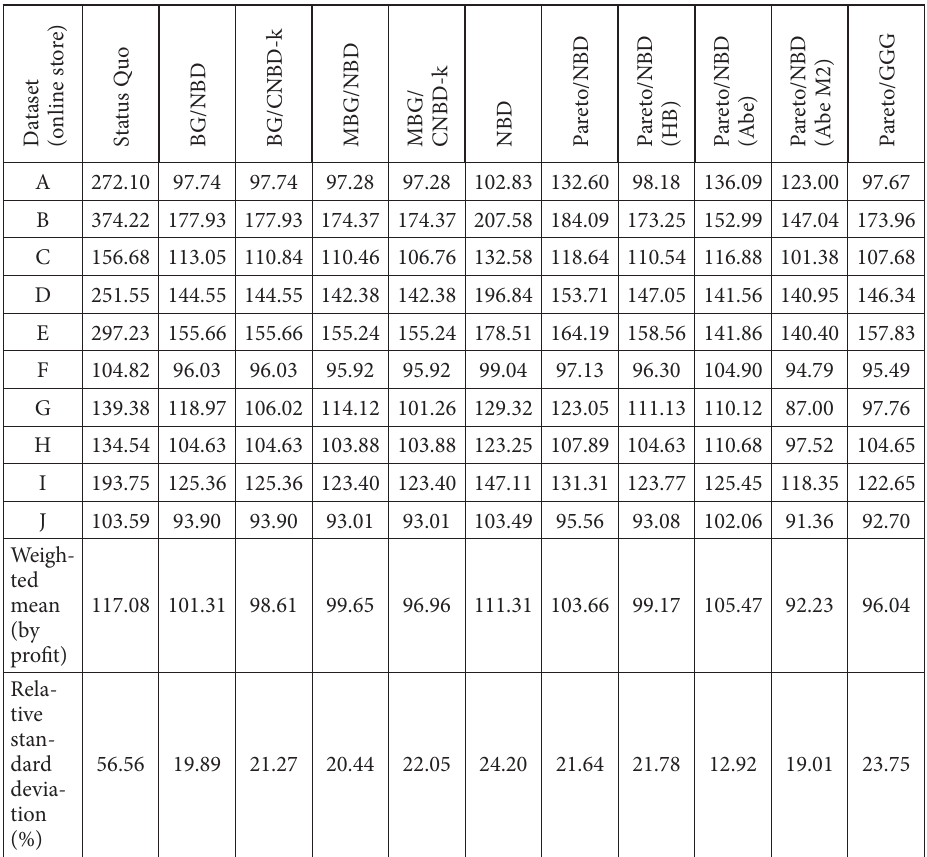
Table 4. Results for MAE (customer-level, in